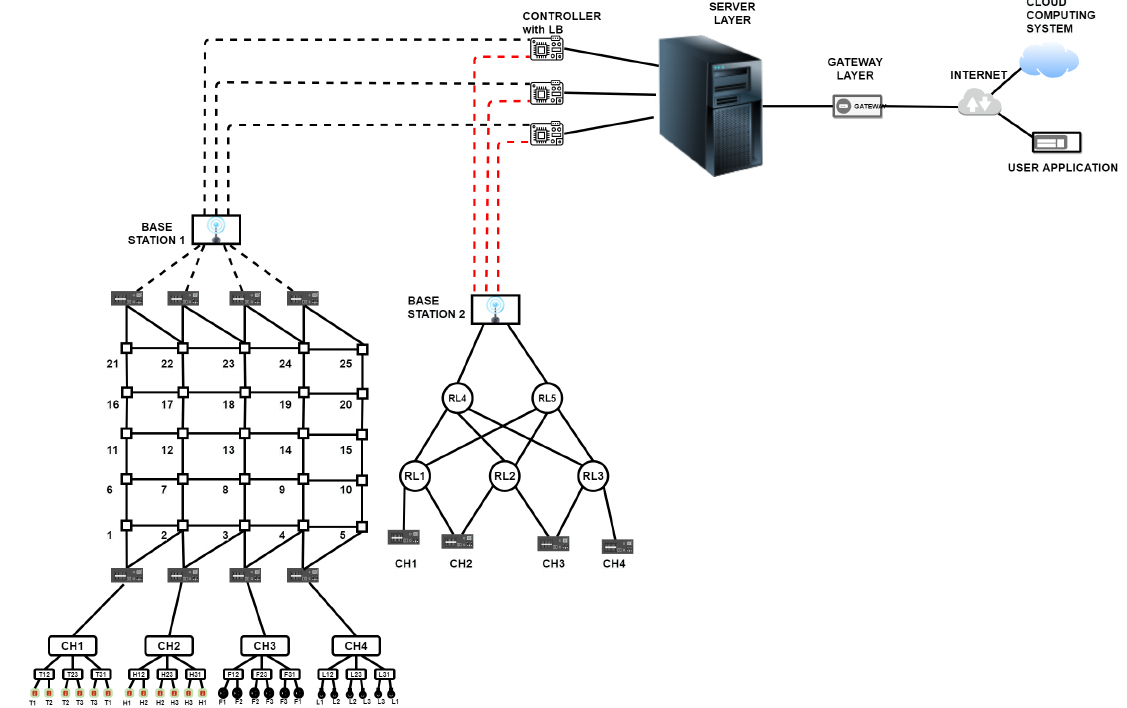
Figure 4. Revised IoT diagram with redundancy created at the base station and controller levels. The following changes have been made in the controller